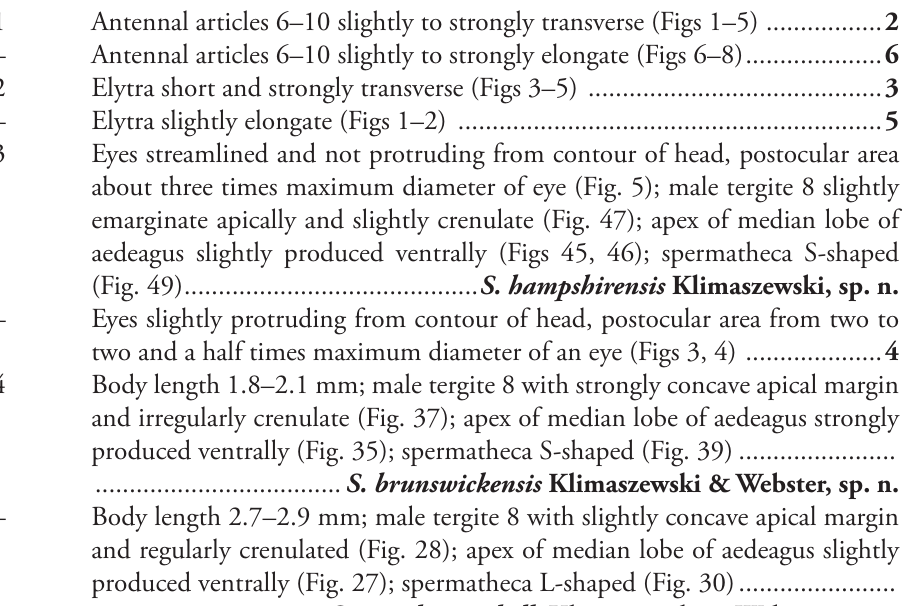
3 Eyes streamlined and not protruding from contour of head, postocular area about three times maximum diameter of eye (Fig. 5); male tergite 8 slightly emarginate apically and slightly crenulate (Fig. 47); apex of median lobe of aedeagus slightly produced ventrally (Figs 45, 46); spermatheca S-shaped (Fig. 49) ........................................... S. hampshirensis Klimaszewski, sp. n. – Eyes slightly protruding from contour of head, postocular area from two to two and a half times maximum diameter of an eye (Figs 3, 4) .................... 4 4 Body length 1.8–2.1 mm; male tergite 8 with strongly concave apical margin and irregularly crenulate (Fig. 37); apex of median lobe of aedeagus strongly produced ventrally (Fig. 35); spermatheca S-shaped (Fig. 39) ....................... .................................... S. brunswickensis Klimaszewski & Webster, sp. n. – Body length 2.7–2.9 mm; male tergite 8 with slightly concave apical margin and regularly crenulated (Fig. 28); apex of median lobe of aedeagus slightly produced ventrally (Fig. 27); spermatheca L-shaped (Fig. 30) ....................... 5 Maximum width of pronotum distinctly less than width of elytra at shoulders (Fig.1); elytral ratio of maximum length to maximum width 0.7 (Fig. 1); apical margin of tergite 8 with two larger lateral teeth and lacking regular crenulation (Fig. 12); spermatheca L-shaped (Fig. 14) ..... S. charlottae Klimaszewski, sp. n. – Maximum width of pronotum about the same as width of elytra at shoulders (Fig. 2); elytral ratio of maximum length to maximum width 0.8 (Fig. 2); apical margin of male tergite 8 with two larger lateral teeth and regular crenulation (Fig. 20); spermatheca S-shaped (Fig. 22) ............. S. campbellii Klimaszewski sp. n. Body length 2.8–3.0 mm, elytra broadening posteriorly (Fig. 7); median lobe of aedeagus and spermatheca as illustrated (Figs 61, 62, 65) ......................... ............................................................... S. carexiana Klimaszewski, sp. n. – Body length 2.3–2.5 mm, elytra subparallel (Figs 6, 8) .............................. 7 7 Elytra as long as pronotum at suture (Fig. 6); postocular area approximately as long as three times maximum diameter of eye seen from above (Fig. 6); median lobe of aedeagus with slightly sinuate venter of tubus and narrowly elongate apex (Fig. 54); spermatheca with capsule lacking invagination (Fig. 57) .................................... S. sphagnorum Klimaszewski & Webster, sp. n. – Elytra longer than pronotum at suture (Fig. 8); postocular area approximately as long as two times maximum diameter of eye seen from above (Fig. 8); median lobe of aedeagus with strongly sinuate venter of tubus and short and blunt apex (Fig. 70); spermatheca with capsule bearing large invagination (Fig. 73) ....................................... S. blatchleyi (Bernhauer &